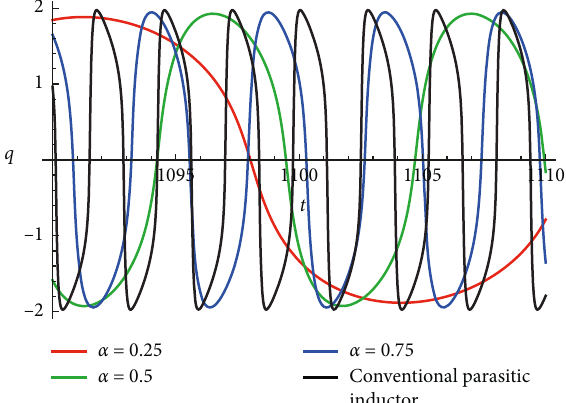
Figure 18: q vs t of the memristor-capacitor circuit with the nonlinear parasitic fractional inductor/nonlinear conventional parasitic inductor.